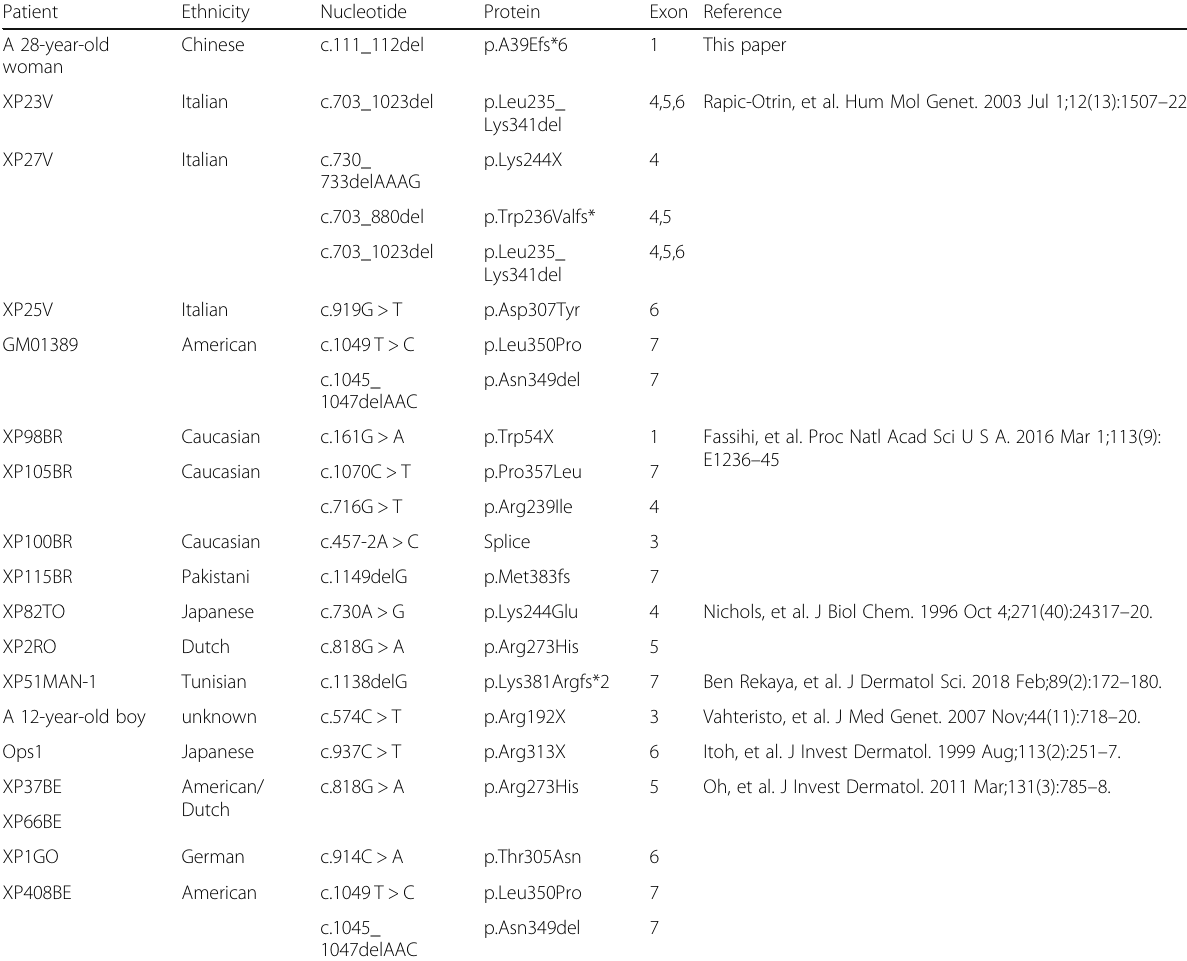
Table 1 Summary of DDB2 mutations based on GenBank accession no. NM_000107.3